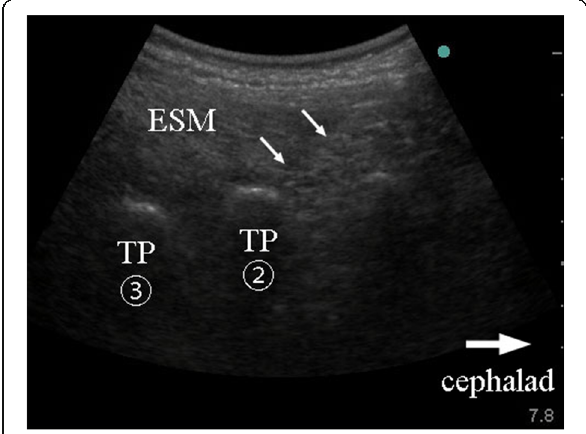
Fig. 2 Ultrasound image for guidance during erector spinae plane (ESP) block for the treatment of low back pain in a patient with failed back surgery syndrome. TP(2), transverse process of L2; TP(3), transverse process of L3; ESM, erector spinae muscle white arrow,